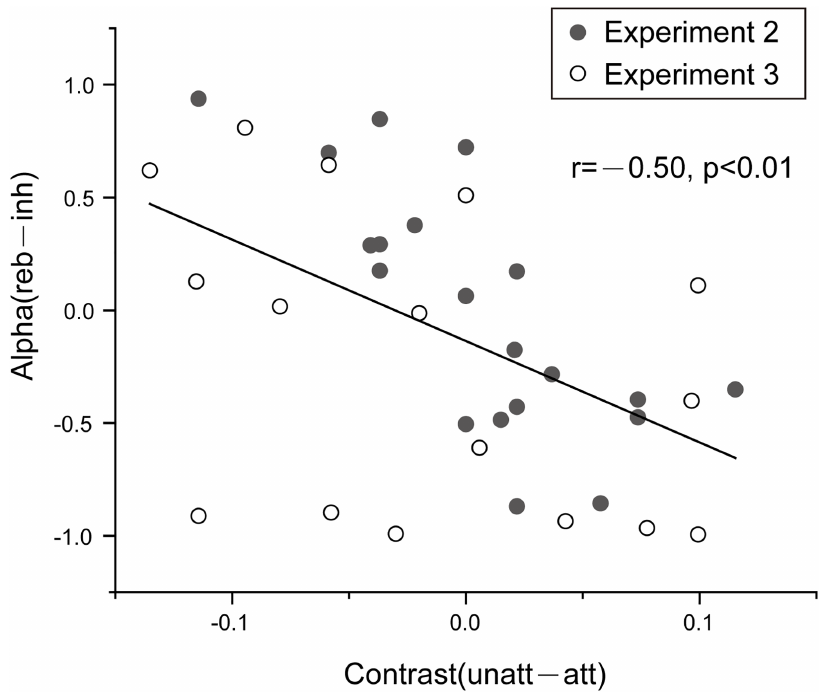
Fig 5. Alpha inhibition-rebound effects relate to attentional behavior. Correlations betweenbehavioral (behavioral index, BI) and alpha switching(neuronalindex, NI) measuresacross participants (Experiment 2: n = 20, disc; Experiment 3: n = 16, circle). BI: Contrast unatt − Contrast att ; NI: alpha reb − alpha inh . The negative correlationsindicate that, as the unattended object obtainedmore attentional behavioralbenefit (smallerBI), the alpha rebound effects became stronger (larger NI). The data are providedin the SupportingInformation (see S4 Data).